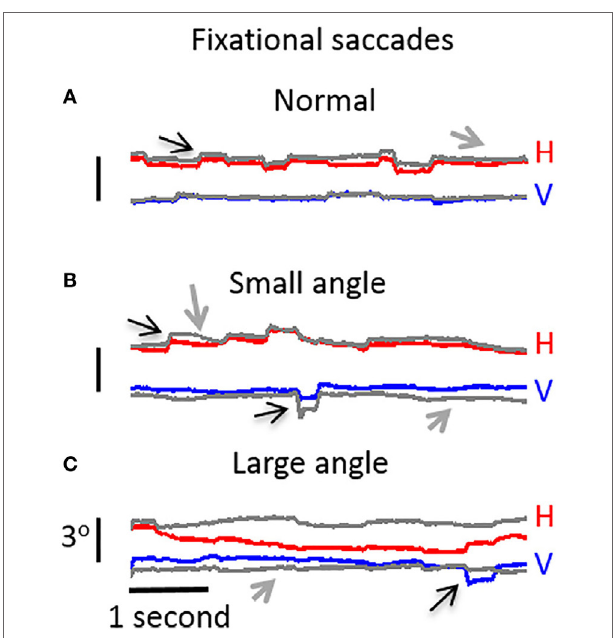
FigURe 4 | Visual fixation of a target for 5 s, under monocular viewing conditions. (A) Participant with normal vision: both microsaccades and intersaccadic drift are conjugate. (B) Participant with small-angle strabismus and stereopsis present: disconjugancy across the two eyes is mild for both microsaccades and drift. (C) Participant with large-angle strabismus and absent stereopsis: disconjugancy is pronounced for both microsaccades and drift. (A–C) Horizontal (red: right eye, gray: left eye) and vertical (blue: right eye, gray: left eye) eye positions are presented. Black arrows indicate microsaccades, and gray arrows represent intersaccadic drift. From Ghasia et al.